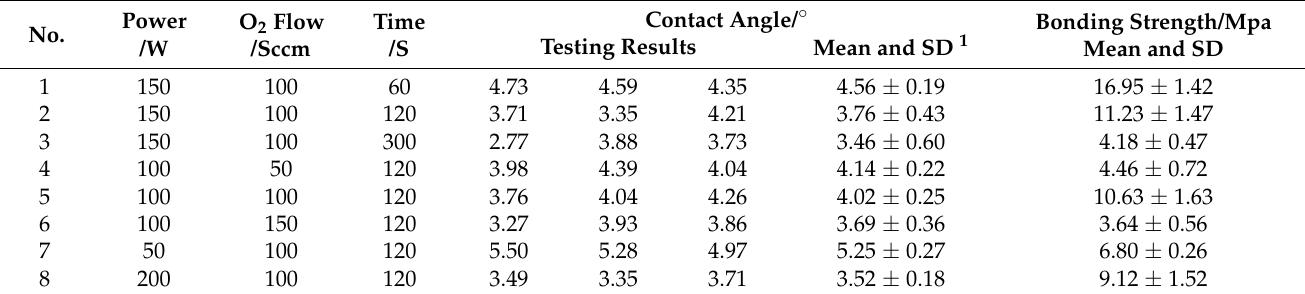
Figure 3. Contact angle of Si wafer surfaces at different conditions. ( a ) Bare Si wafer without activation; ( b ) After wet cleaning by SC1 solution; ( c ) After O 2 plasma activation with power of Table 1. Bonding samples with different O 2 plasma activation parameters. Table 1. Bonding samples with different O 2 plasma activation parameters.